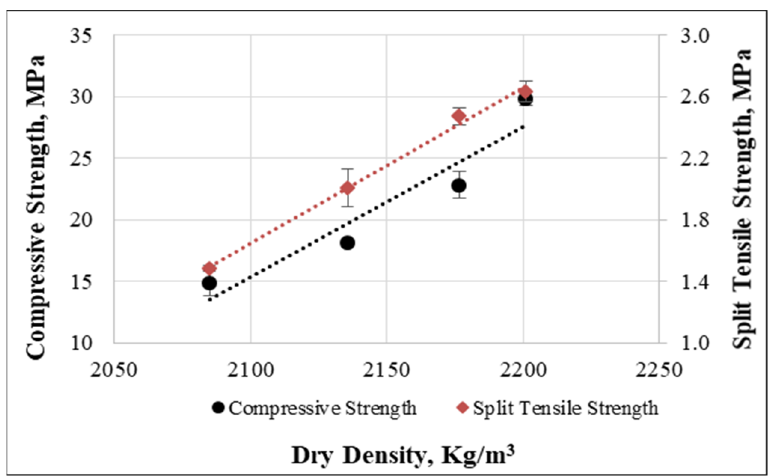
Figure 25. Relationship between dry density, compressive and tensile split strengths.